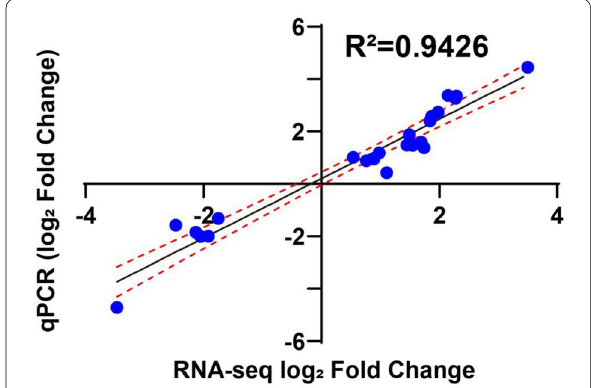
Fig. 7 Correlation between RNA-seq and RT-qPCR. Comparison of the log 2 -fold change of 22 genes obtained by RNA-seq and RT-qPCR. RT-qPCR was performed using the amplified cDNA from each RNA-seq sample. A strong, statistically significant Pearson correlation is observed between the expression levels measured using RT-qPCR and